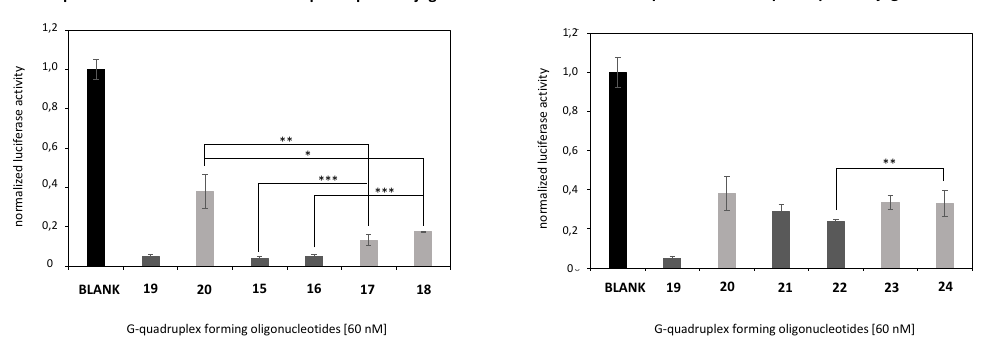
Figure 7. Gene transfection studies targeting Renilla luciferase mRNA in the presence of Lipofectamine 2000 involving antisense G-quadruplex forming oligonucleotides 15-24 at 60 nM. Two series of conjugates containing four and six guanines were studied. ( A ) antisense G-rich modified with lipid threoninol-based building blocks at the 3 ′ -termini and ( B ) lipids were conjugated by modifying the 5 ′ -termini of the G-rich oligonucleotide. Two alkyl chains were selected according to their length (C8 and C14). Two unmodified G-rich oligonucleotides were used as controls ( 19 and 20 ). Data were means ±SD of three to six independent experiments. A regular two-way ANOVA variance analysis combined with Bonferroni post-test for multiple comparisons was evaluated (* p < 0.05, ** p < 0.01 and *** p < 0.001).